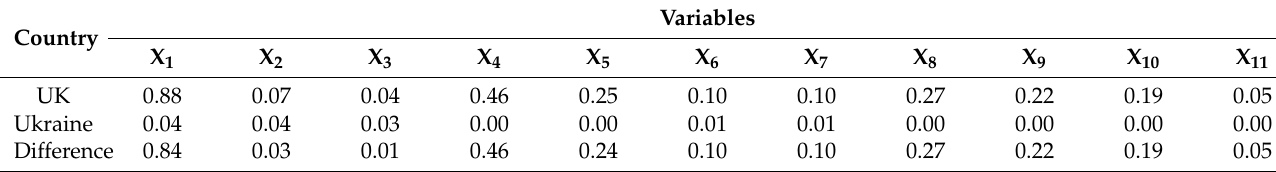
Table 5. Values of variables for the UK and Ukraine